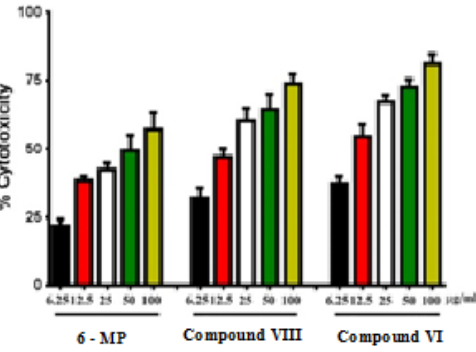
Figure (2) Anti-proliferative activity of 6MP, compound VI, VIII against SKO-3 cell